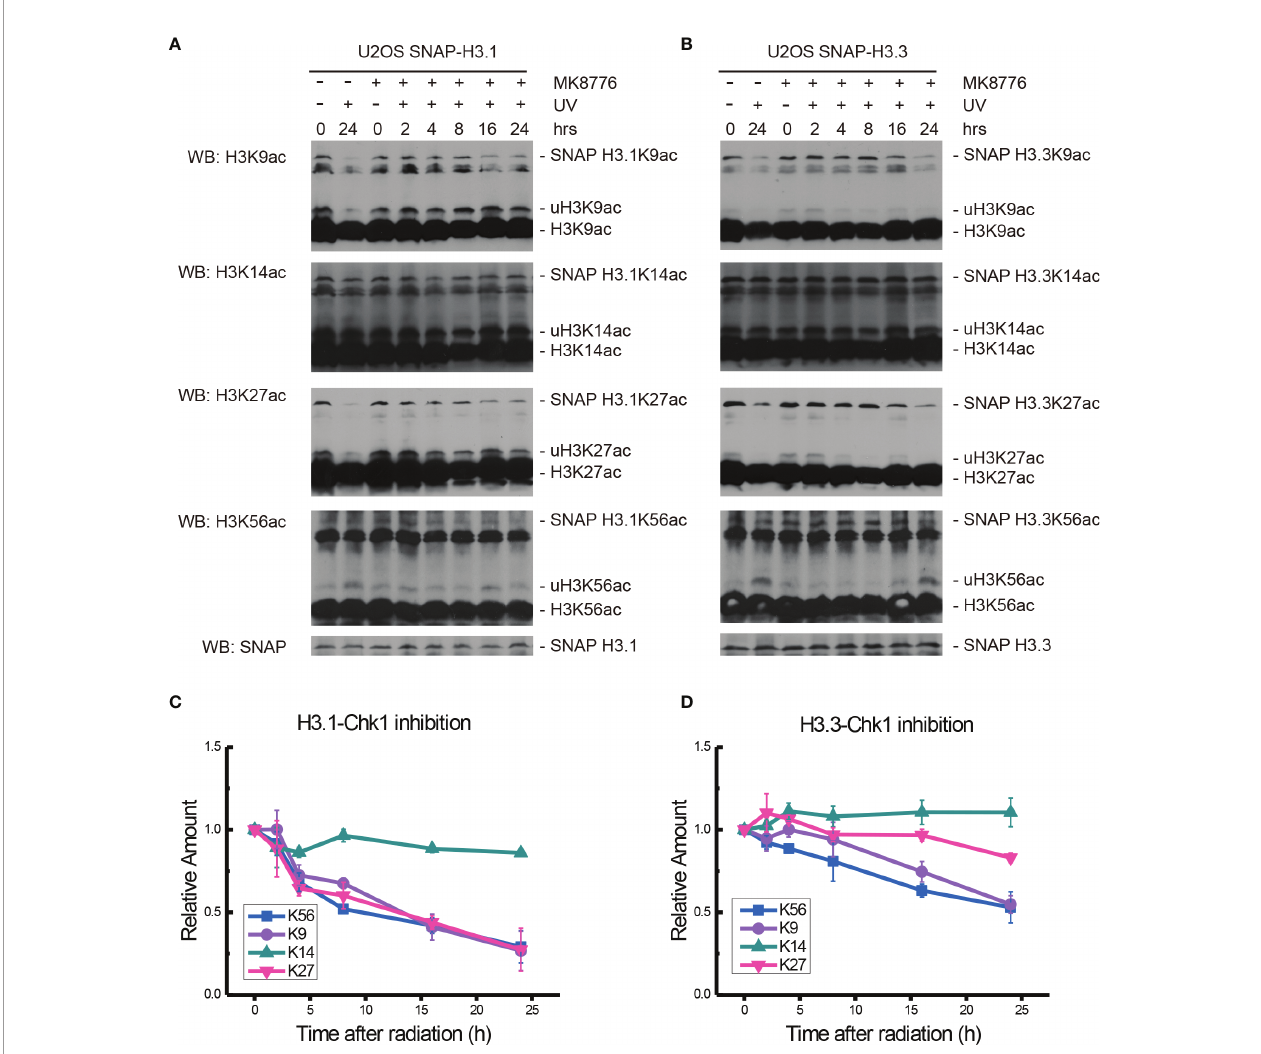
FIGURE 5 | Modulation of acetylated K9, K14, K27, and K56 of histone H3.1 or H3.3 by the Chk1 inhibitor MK8776 and UV radiation. (A) H3.1-SNAP U2OS cells were pretreated with DMSO (-) or MK8776 (+) for 1 h and then irradiated with 20 J/m 2 UV radiation. The insoluble nuclear protein samples were collected at 0 h, 2 h, 4 h, 8 h, 16 h, and 24 h after radiation. The acetylation levels of H3K9, H3K14, H3K27, and H3K56 were examined. SNAP-tagged histone H3 was used as an internal reference. (B) H3.3-SNAP U2OS cells were pretreated with DMSO or MK8776 and then irradiated with 20 J/m 2 UV radiation. The insoluble nuclear protein samples were collected, and the acetylation levels of H3K9, H3K14, H3K27, and H3K56 were examined. SNAP-tagged histone H3 was used as an internal reference. (C) Time- course alteration of acetylated K9, K14, K27, and K56 of histone H3.1 after 20 J/m 2 UV radiation and MK8776 treatment. The data are normalized immunoblotting results by ImageJ analysis from three separate experiments. (D) Time-course alteration of acetylated K9, K14, K27, and K56 of histone H3.3 after 20 J/m 2 UV radiation and MK8776 treatment. The data are normalized immunoblotting results by ImageJ analysis from three separate